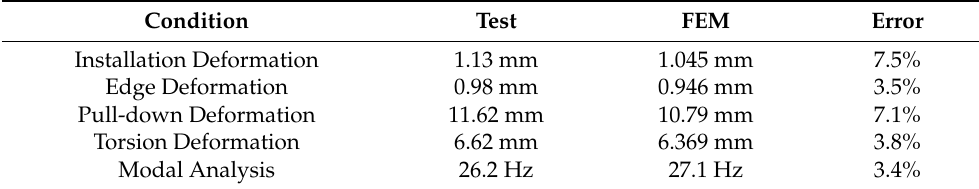
Table 4. Comparison of results of different working conditions.